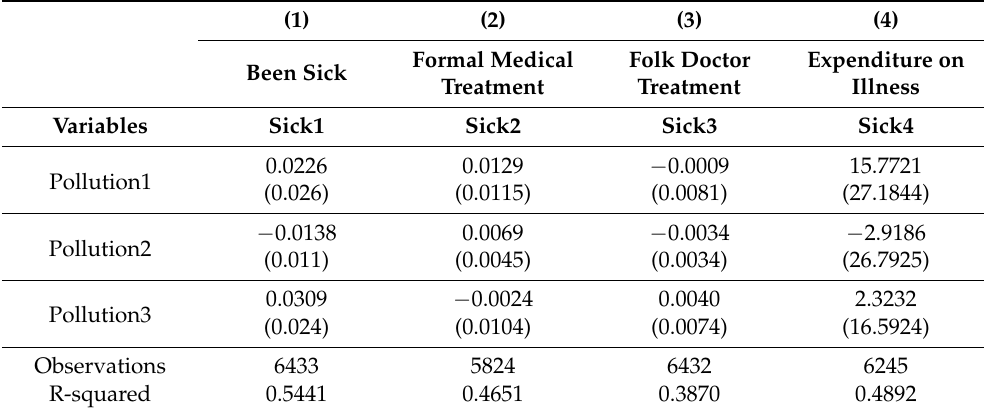
Table 5. Effects of upstream pollutant emissions on downstream residents’ health.